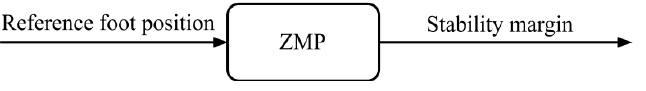
Figure 5. The input and output of ZMP method for quadruped robot.